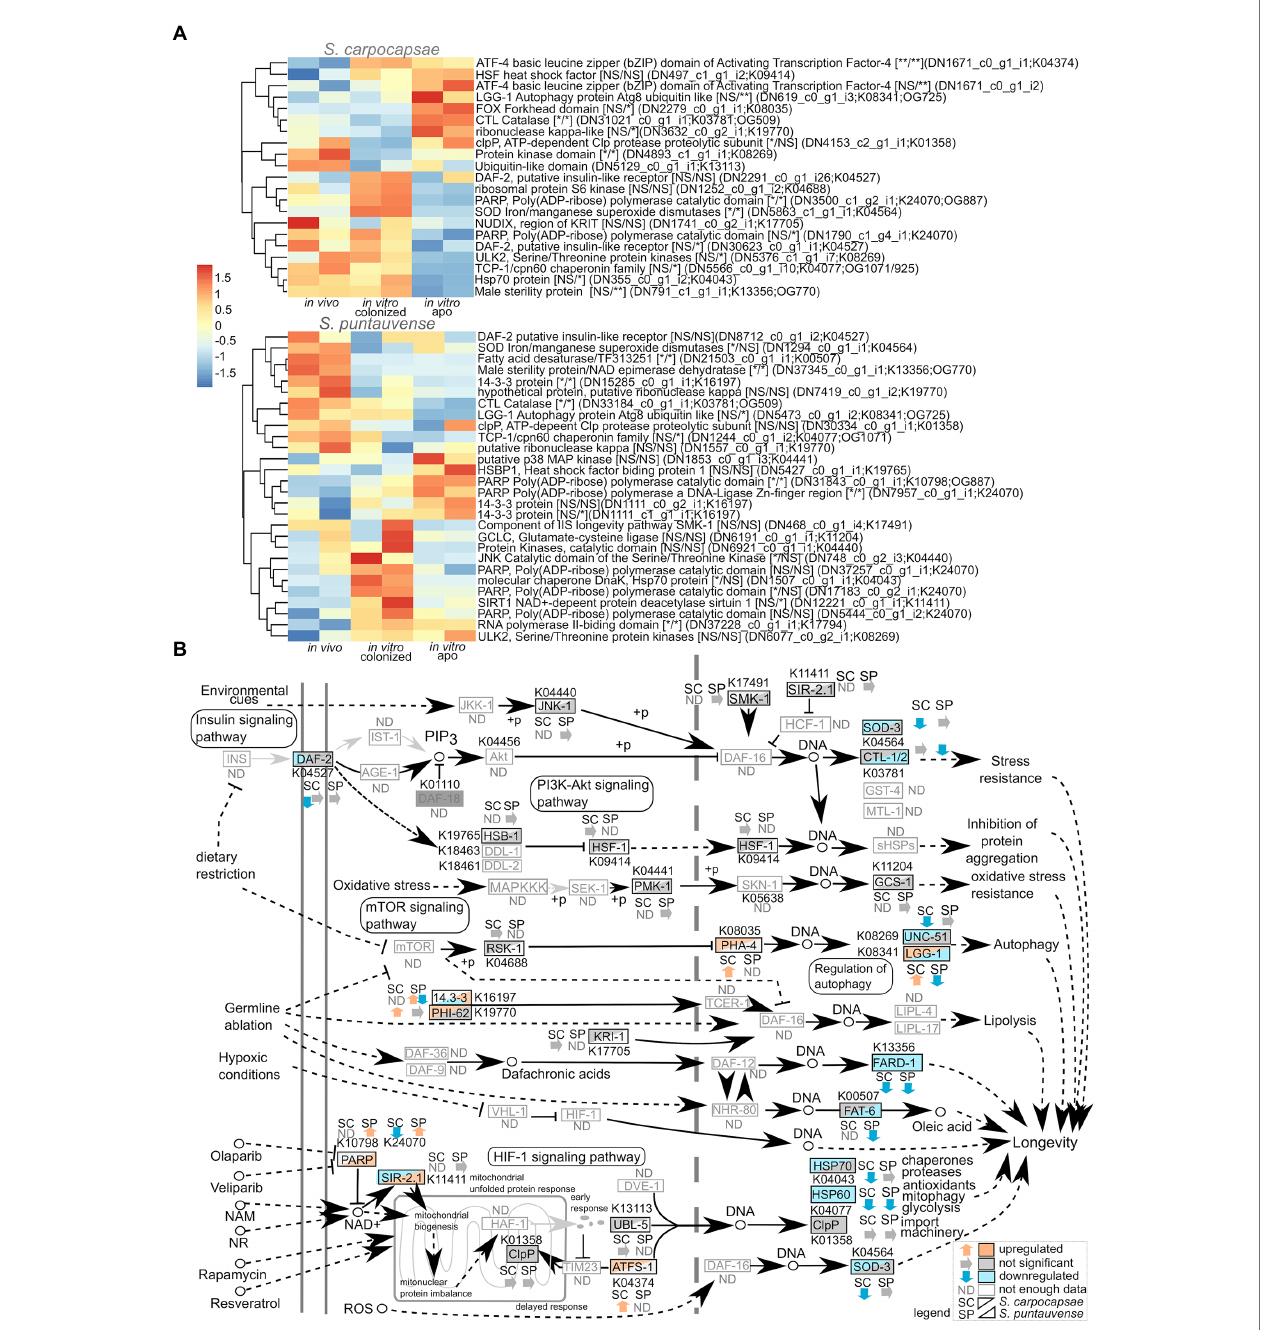
FIGURE 8 | Transcriptomic analysis of genes involved in the longevity regulating pathway. (A) Heatmap of transcripts expression involved in the longevity regulating pathway for the species S. carpocapsae and S. puntauvense produced by pheatmap (values centered and scaled in the row direction). For each condition, the two technical replicates are showed in the heatmap. On the right side of the heatmap supplementary information is indicated including: annotation of the transcription (based on hmmer); significance of differential expression based on cuffdiff and edgeR (“*” denotes statistical significant difference, NS indicates no significant difference), first value for the in vitro colonized rearing condition and the second value for the in vitro aposymbiotic rearing condition; the name of the transcript; the KEGG pathway detected; if applicable, the name of the orthogroup that belongs to the transcript shared among the two species (based on orthofinder analysis). (B) Map of the longevity regulating pathway in nematodes (ko04212) where the observed expression in the in vitro aposymbiotic reared nematodes for Steinernema species is